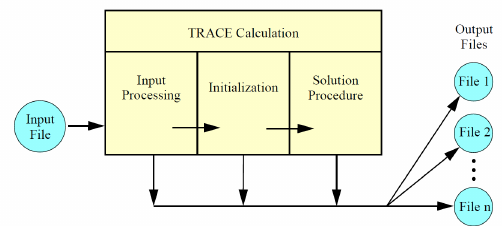
Figure 1. Phases of a TRACE